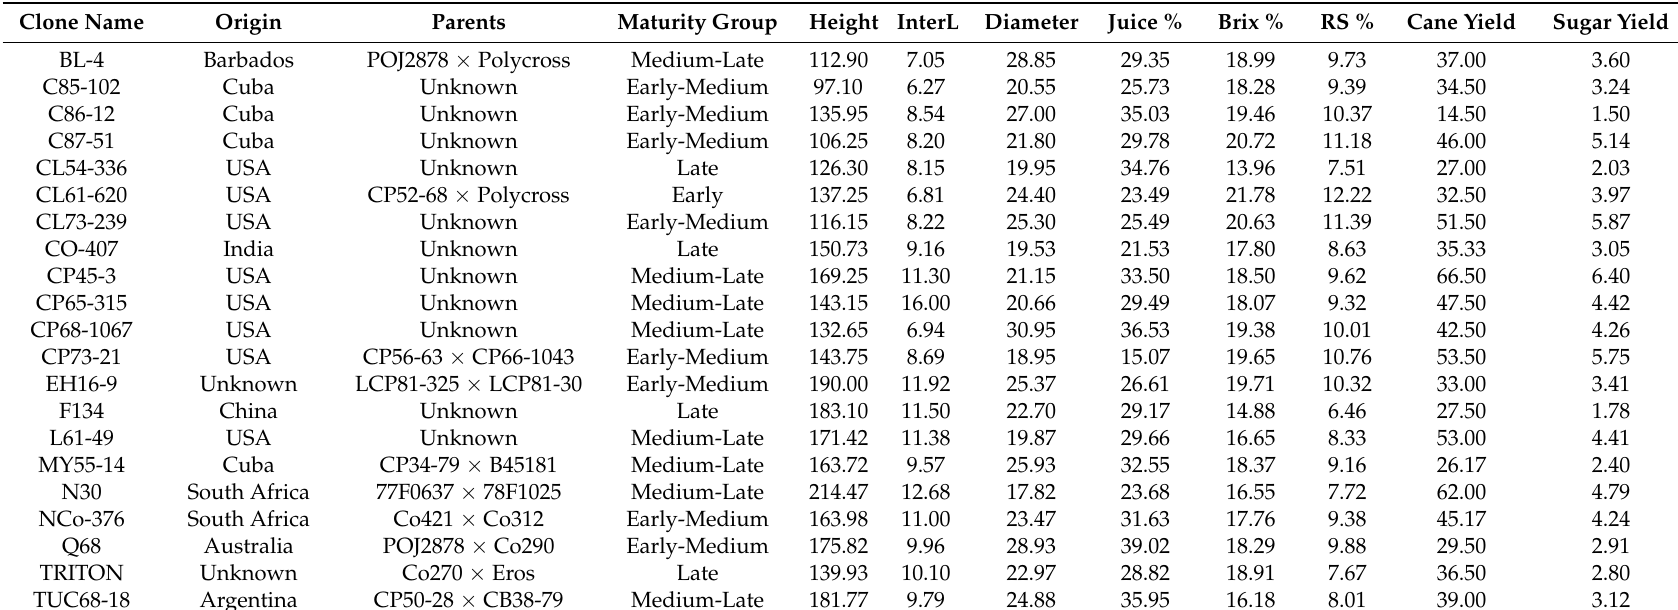
Table 6. Description of 21 sugarcane accessions created by M-strategy and heuristic